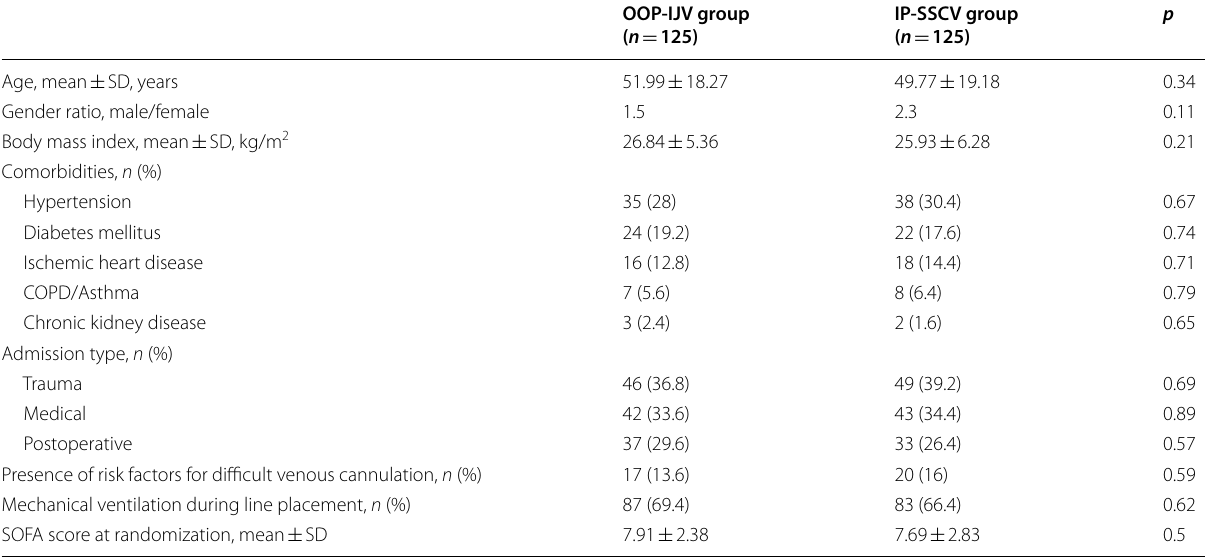
Table 1 Baseline characteristics of the study